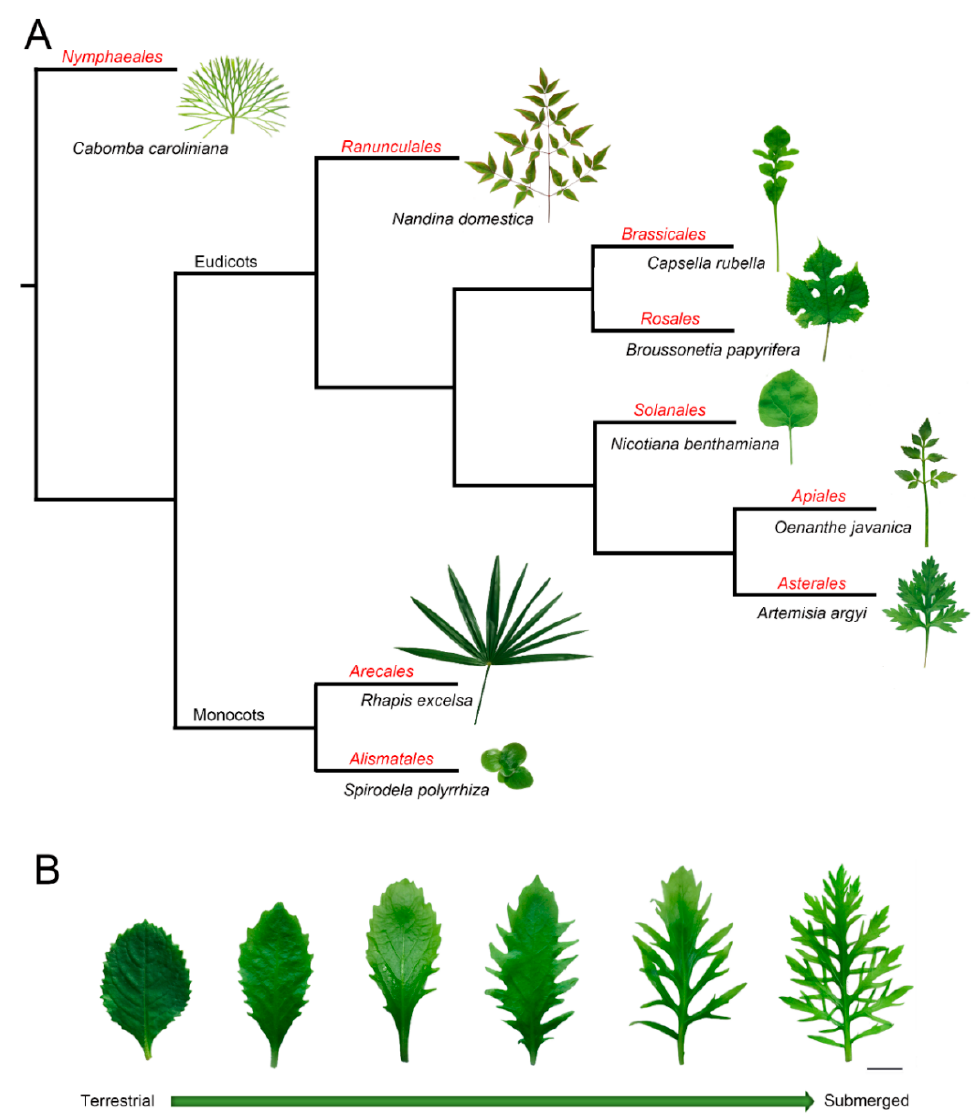
Figure 1. The phylogeny and typical leaf shape among plant species. ( A ) The phylogeny and typical leaf shape among species from different orders. Red text indicates the order name. ( B ) Leaves from a heterophyllous plant ( Hygrophila difformis ) shifted from terrestrial to submerged conditions. Successive leaves are in phyllotactic order. Bar = 1 cm. All photos were taken by the camera (Canon EOS80D, Japan) and plant materials were collected from the Key Laboratory of Aquatic Biodiversity and Conservation of Chinese Academy of Sciences (Institute of Hydrobiology, Chinese Academy of Sciences). The phylogenetic tree was based on the online software “Phylomatic” (http://phylodiversity.net/phylomatic/).